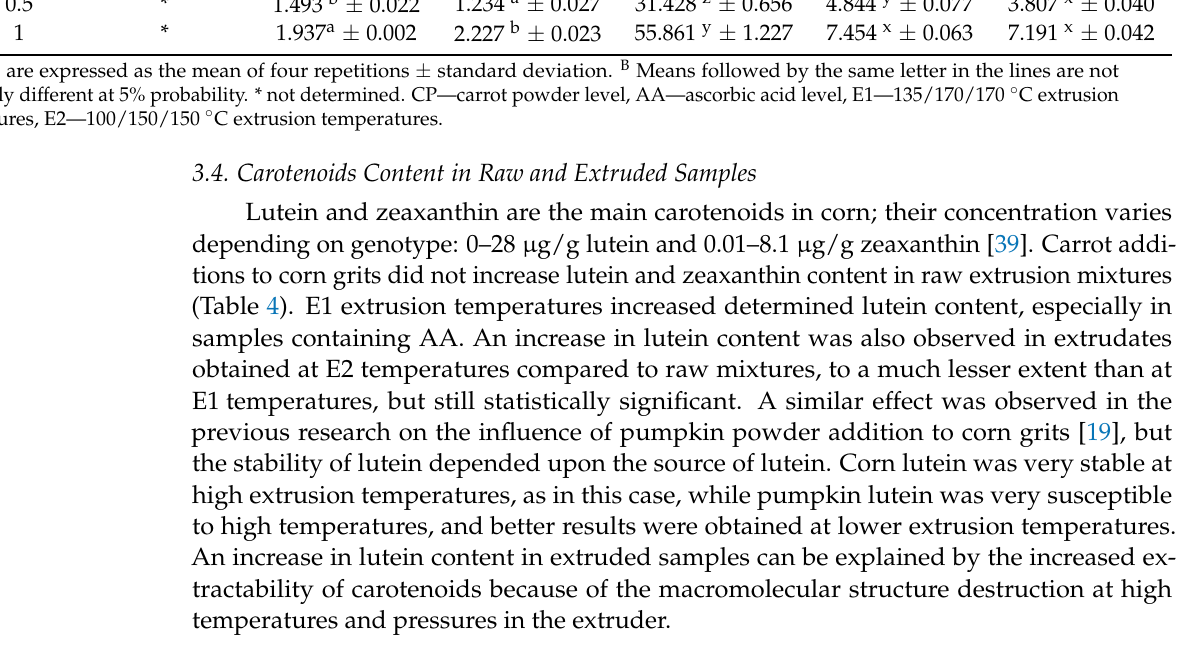
Table 4. Carotenoids content in samples before and after extrusion A